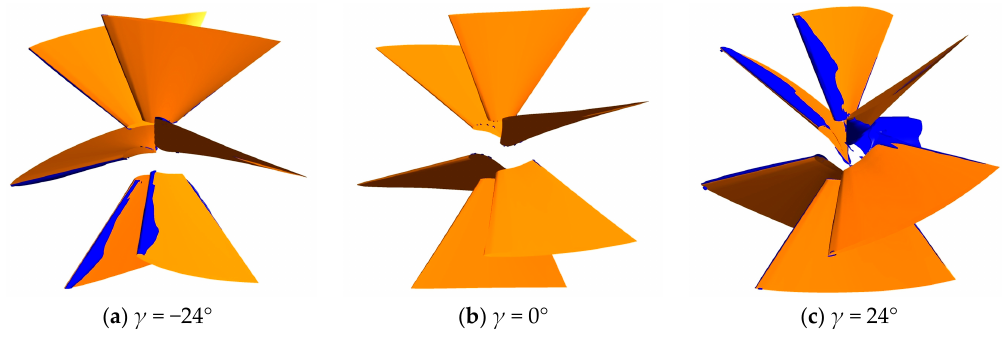
Figure 8. Isosurface of Q = 1.5 × 10 5 s − 2 in the suction pipe for pumps with IGVs. Table 3. Experimental results of the highest efficiencies and corresponding flow rates.